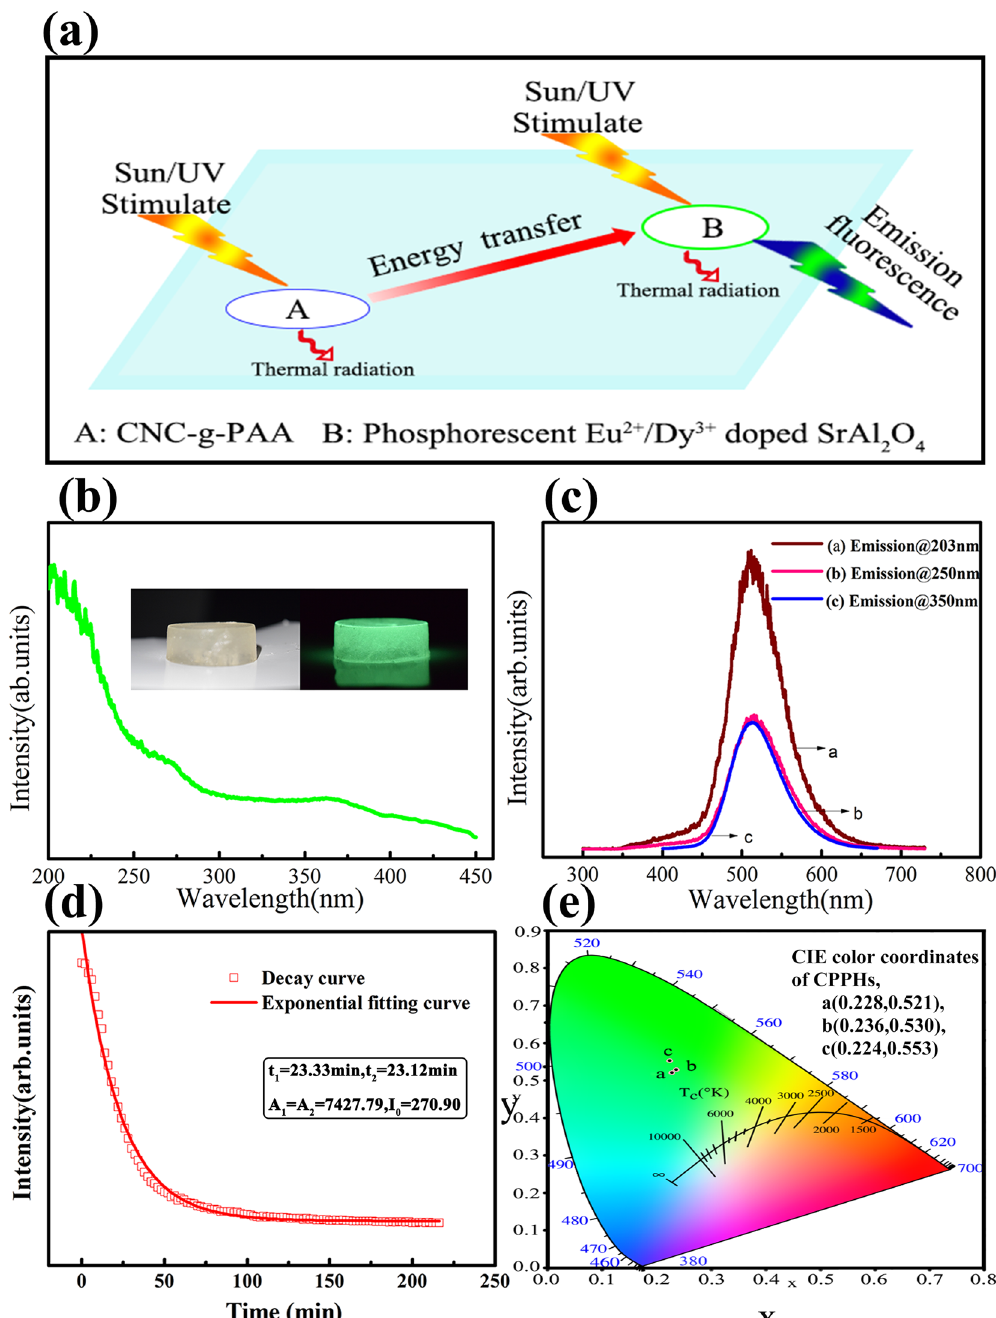
Figure 2. ( a ) Hydrogel luminescence mechanism. ( b ) The excitation spectrum of hydrogel at 513 nm emission wavelength; interleaved patterns show the photographs of hydrogel: the sample with yellowish white color before the excitation treatment of sunlight (the left one), the sample with strong green color after the excitation treatment of sunlight (the right one). ( c ) Photoluminescence spectra of hydrogel at different excitation wavelengths ( λ ex = 203, 250 and 350 nm). ( d ) TRPL afterglow decay curve of hydrogel. ( e ) The photograph of CIE color coordinates of